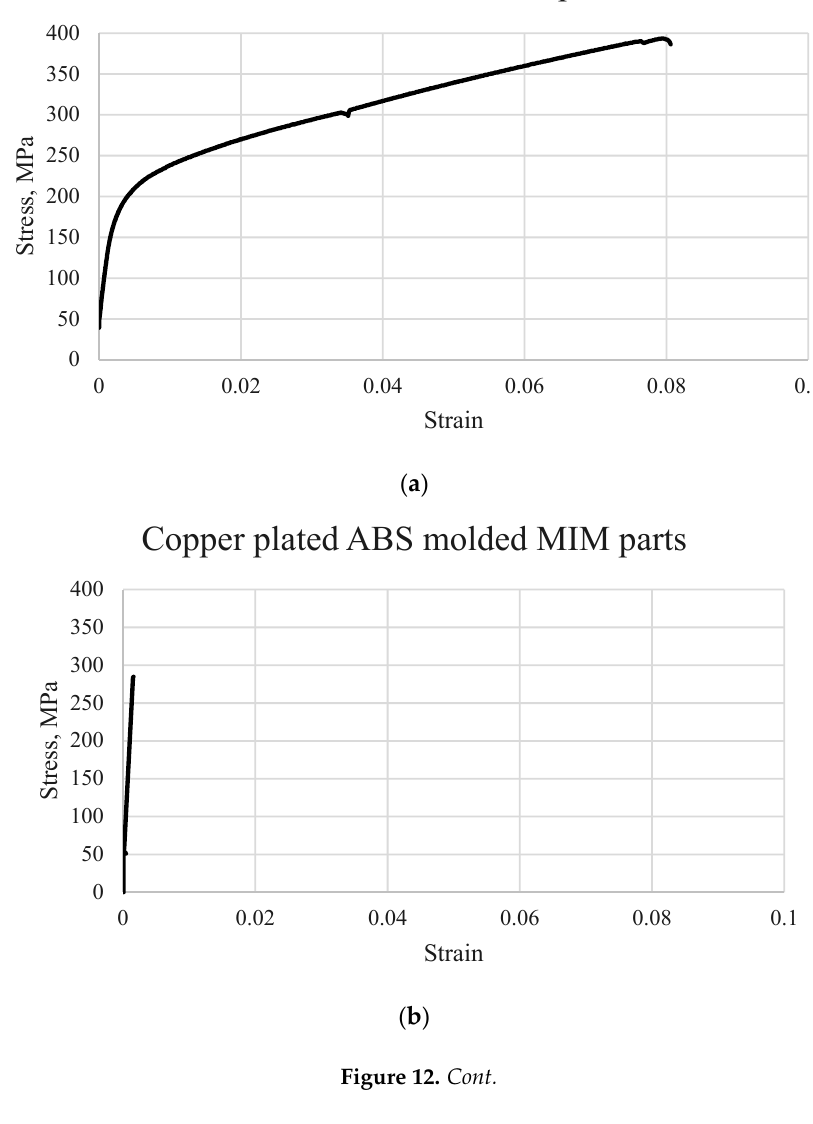
Figure 12a–d indicates the experimental stress-strain curves for the MIM parts molded with the polymer inserts.